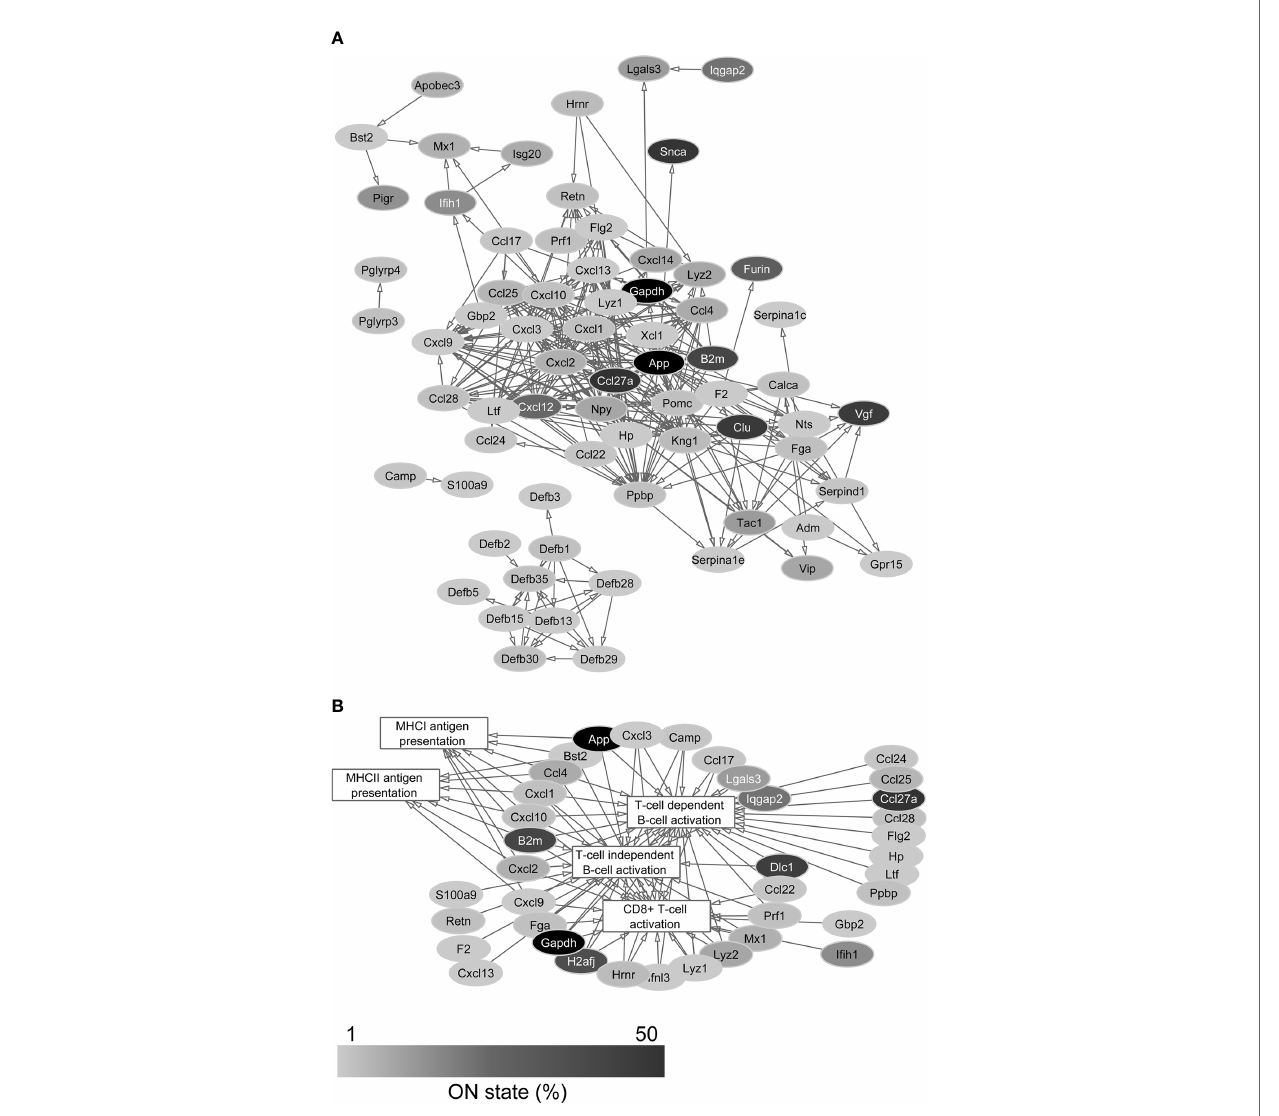
FIGURE 1 | Protein-protein interaction networks of AMPs (A) and their association with immune cell processes (B) . The large number of connections suggests the immunomodulatory function of AMPs besides their antimicrobial role. Gray scale shows the percentage of neurons that expresses the transcript of each protein in the single-cell sequencing data (ON state